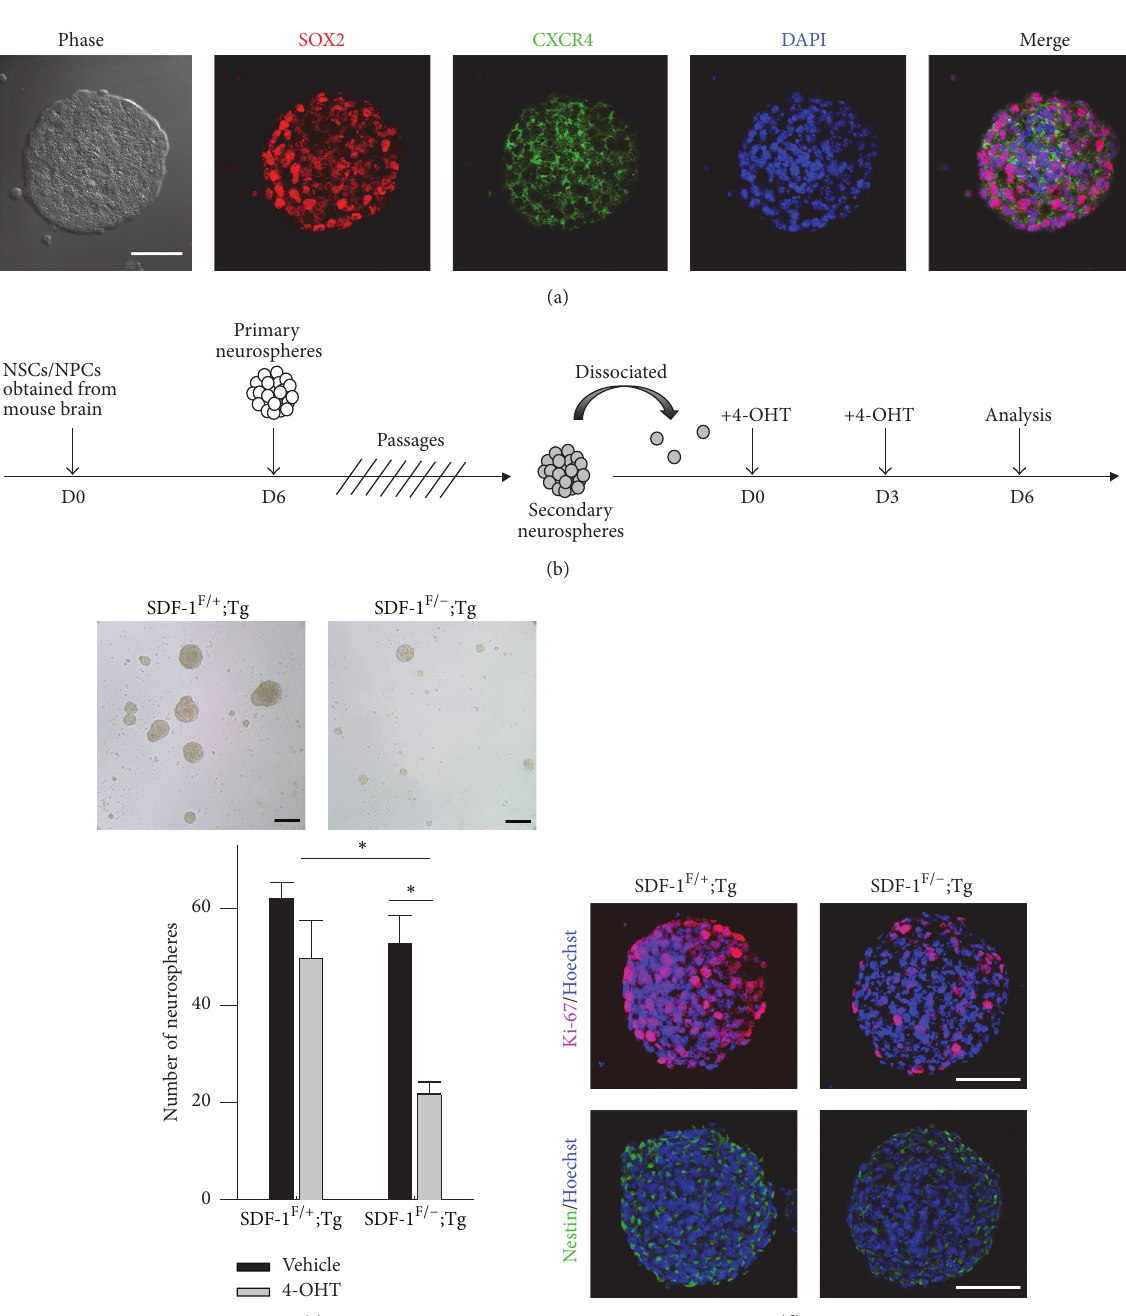
Figure 1: Genetic deletion of SDF-1 gene impairs NSCs/NPCs maintenance. (a) Immunocytochemical staining showed that most cells in neurospheres were SOX2 + and coexpressed CXCR4 receptors. Scale bar, 50 𝜇 m. (b) Schematic representation of the protocol used in this study. (c) Representative images of secondary neurospheres formation after 4-OHT treatment. SDF- 1 F /− ;Tg group showed significant decline in neurospheres outgrowth compared to SDF- 1 F /+ ;Tg group (upper panel). Scale bar, 100 𝜇 m. Quantification of sphere numbers in SDF- 1 F /+ ;Tg and SDF- 1 F /− ;Tg group after vehicle or 4-OHT application (lower panel). Results are representative of three independent experiments with NSCs/NPCs from three independent litters. Data represent the mean ± SEM, ∗ 𝑝 < 0.05 , Student’s 𝑡 -test. (d) Immunocytochemistrical staining of Ki-67 (red, upper panel) and nestin (green, lower panel) in neurospheres after 4-OHT-induced deletion of SDF-1. Scale bar, 50 𝜇